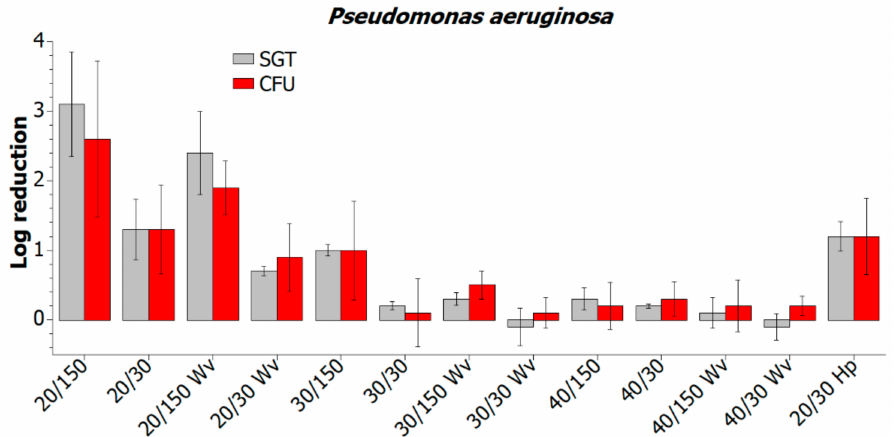
Figure 4. Comparison of decontamination efficiency of plasma-activated and not-activated water vapor (“Wv”) in remote distances evaluated by the SGT and CFU